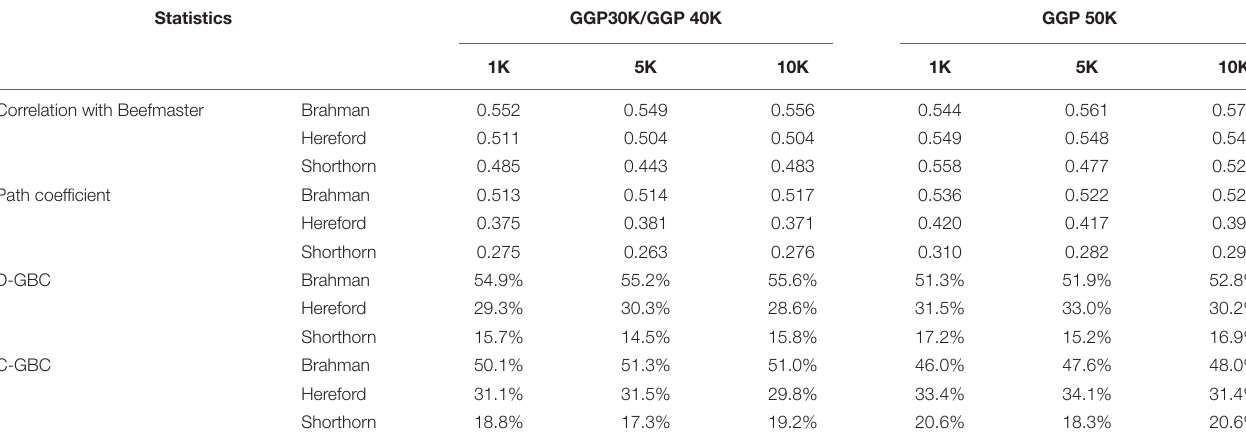
TABLE 6 | Path analysis using the correlation data for 7,605 Beefmaster animals with three ancestral breeds as the reference and three SNP panels. Statistics